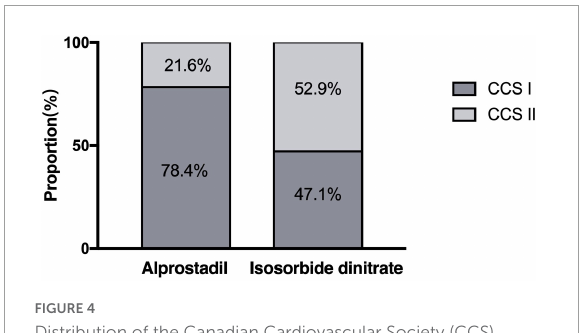
FIGURE4 Distribution of the Canadian Cardiovascular Society (CCS) classification of angina episodes after 1-month treatment of alprostadil and isosorbide dinitrate (proportions). Statistical analysis was performed using the chi-square